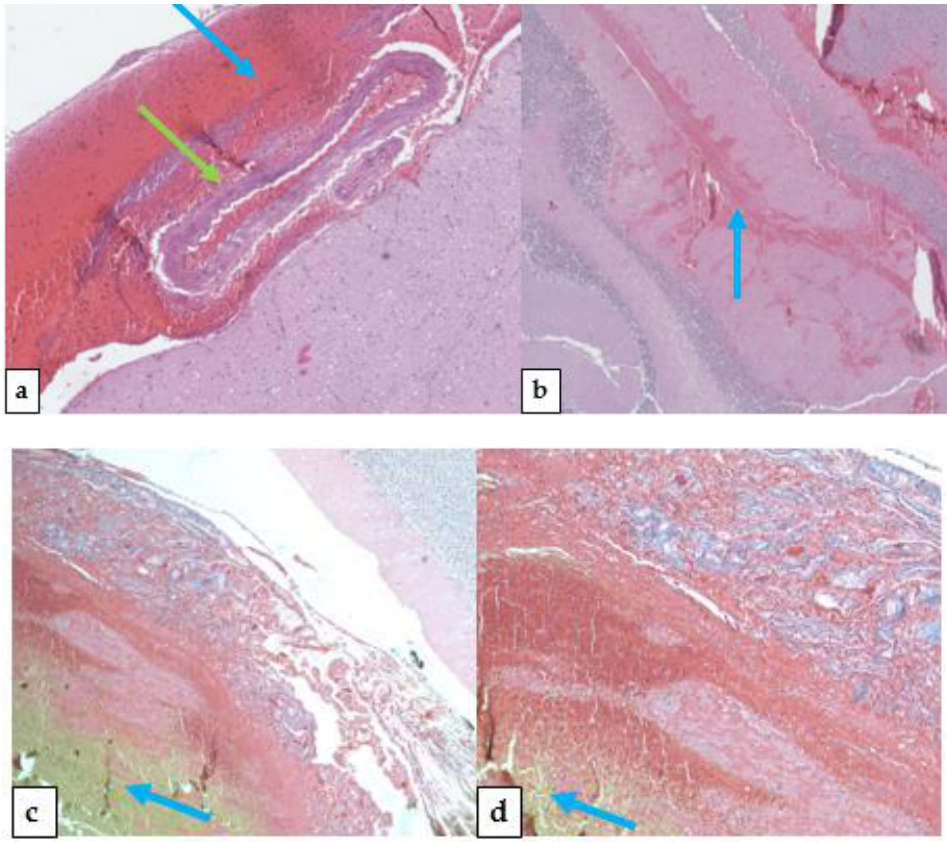
Figure 6. Different histological findings across the cerebellum. Peripheral examination showed flattened vessels green arrow) (( a )-green arrow indicates flattened vessels, blue arrow indicates the points of massive bleeding) and massive hemorrhage ( b ). Massive hemorrhage signs were also found inside the cerebellum parenchyma ( b ). During sampling procedures, the specific broken vessel was not identified, but the overall vessel structure was more represented than usual, especially on the upper side of the cerebellum, confirming the underlying arterio-venous disorder. Masson’s trichrome stain of the cerebellum ( c , d ): cytoplasm, keratin, acidophilic granulocytes in red; collagen in blue; erythrocytes in